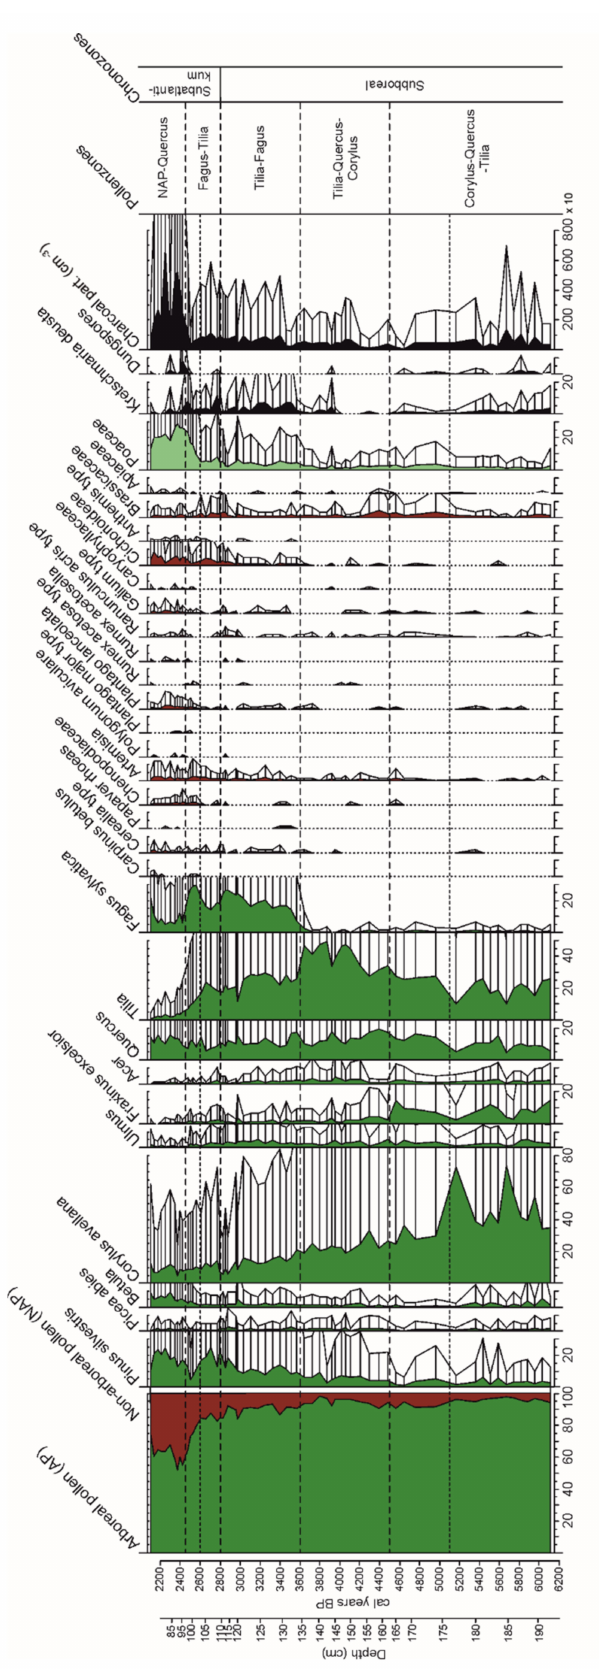
Figure 5. Pollen diagram